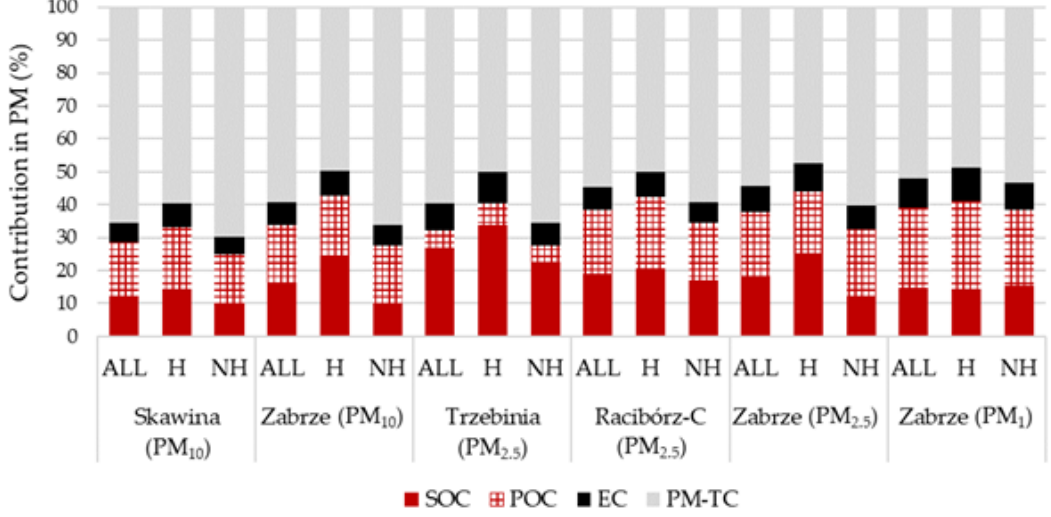
Figure 7. Average contributions of carbonaceous compounds (EC, SO, POC) in PM mass (%) at considered urban background sites.